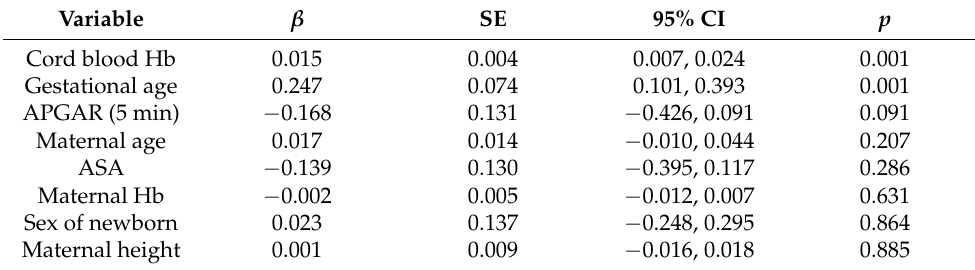
Table 4. Multiple linear regression analysis of birth weight to placental weight ratio ( r 2 =